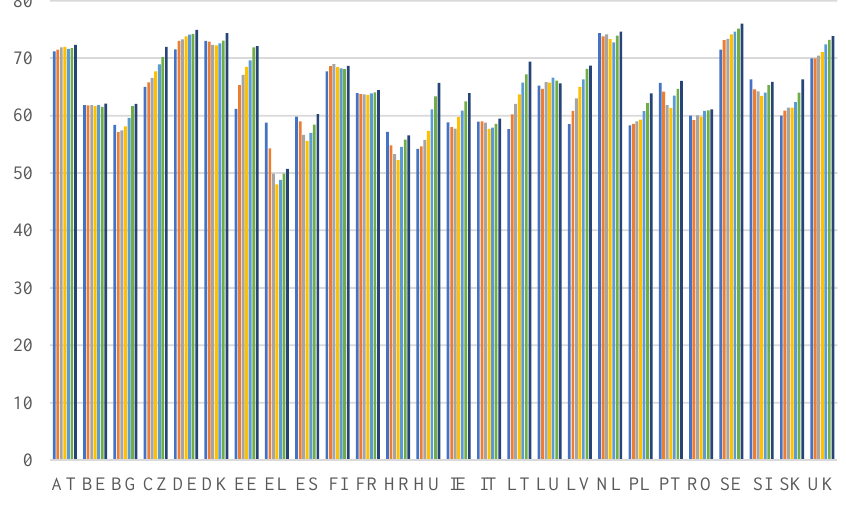
Figure 2. Performance of countries’ average employment rates 2010–2016 in %